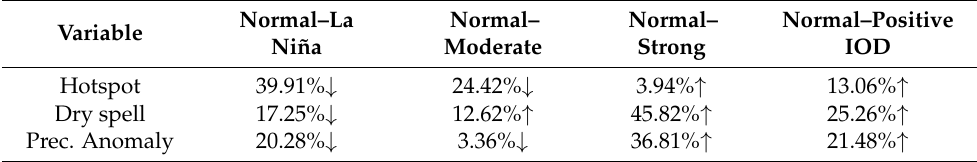
Table 5. Mid-year dry season—difference value of the PDF from years categories. Variable